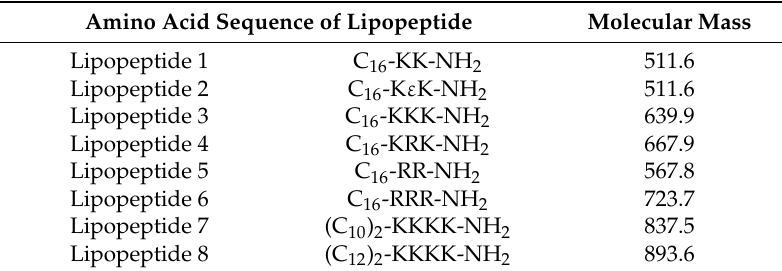
Table 3. Amino acid sequences and molecular masses (Da) of the